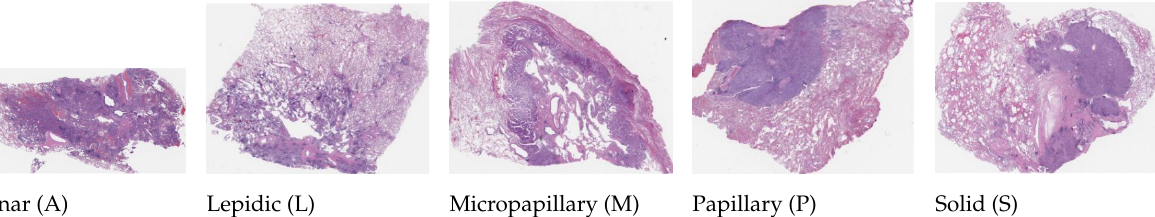
Figure 3. Histological images of five types of lung adenocarcinoma in the Dartmouth Lung Can- cer dataset. Table 3. Structure of the Dartmouth Lung Cancer dataset (31 WSIs only) with 20 × magnification